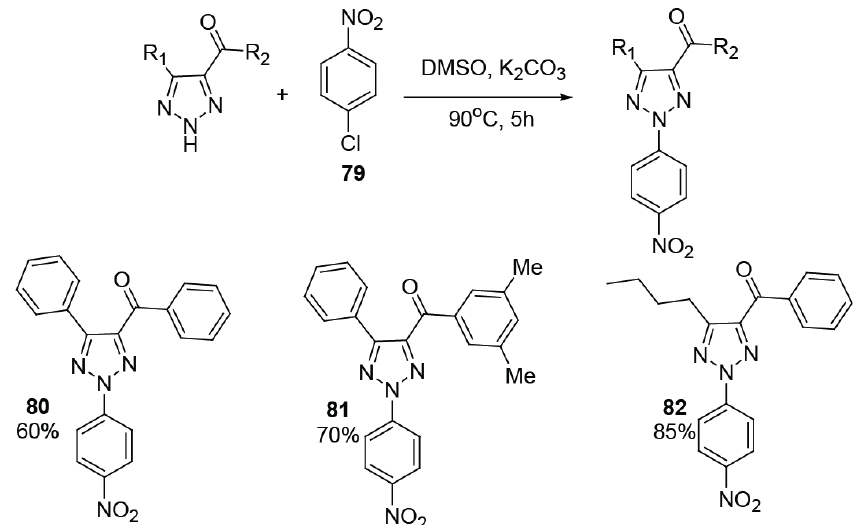
Figure 14 - Complete N 2 -Regioselective arylation of 4,5-dissubstitued 1,2,3-triazoles with chloro-nitro Benzene.